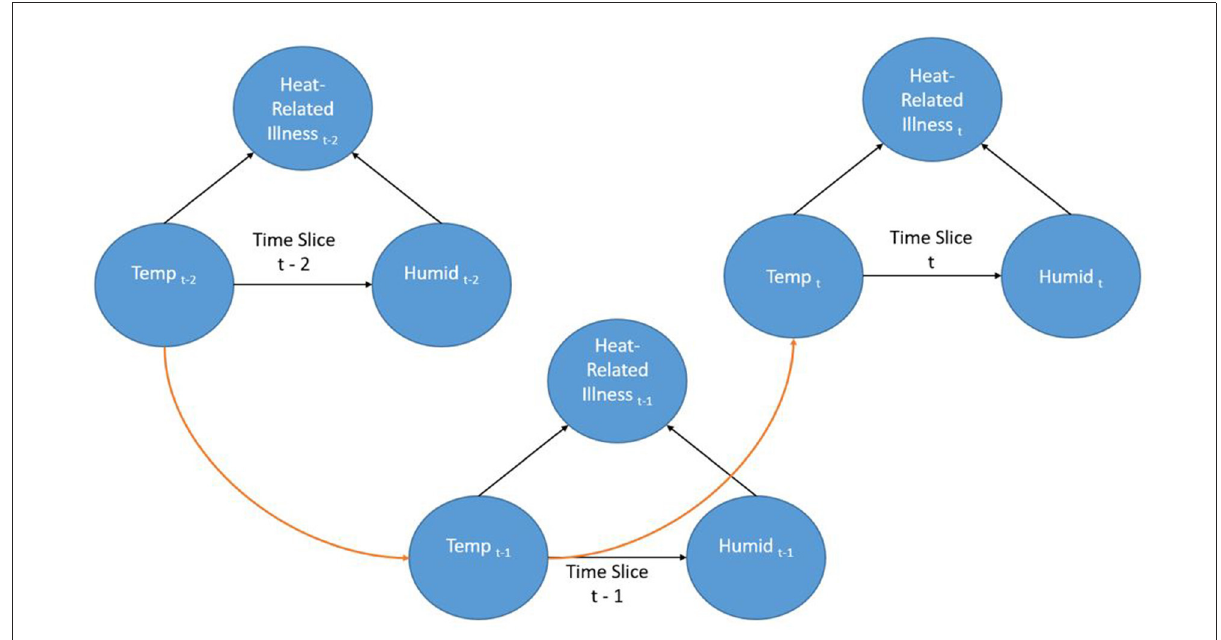
FIGURE2 A simple Dynamic Bayesian